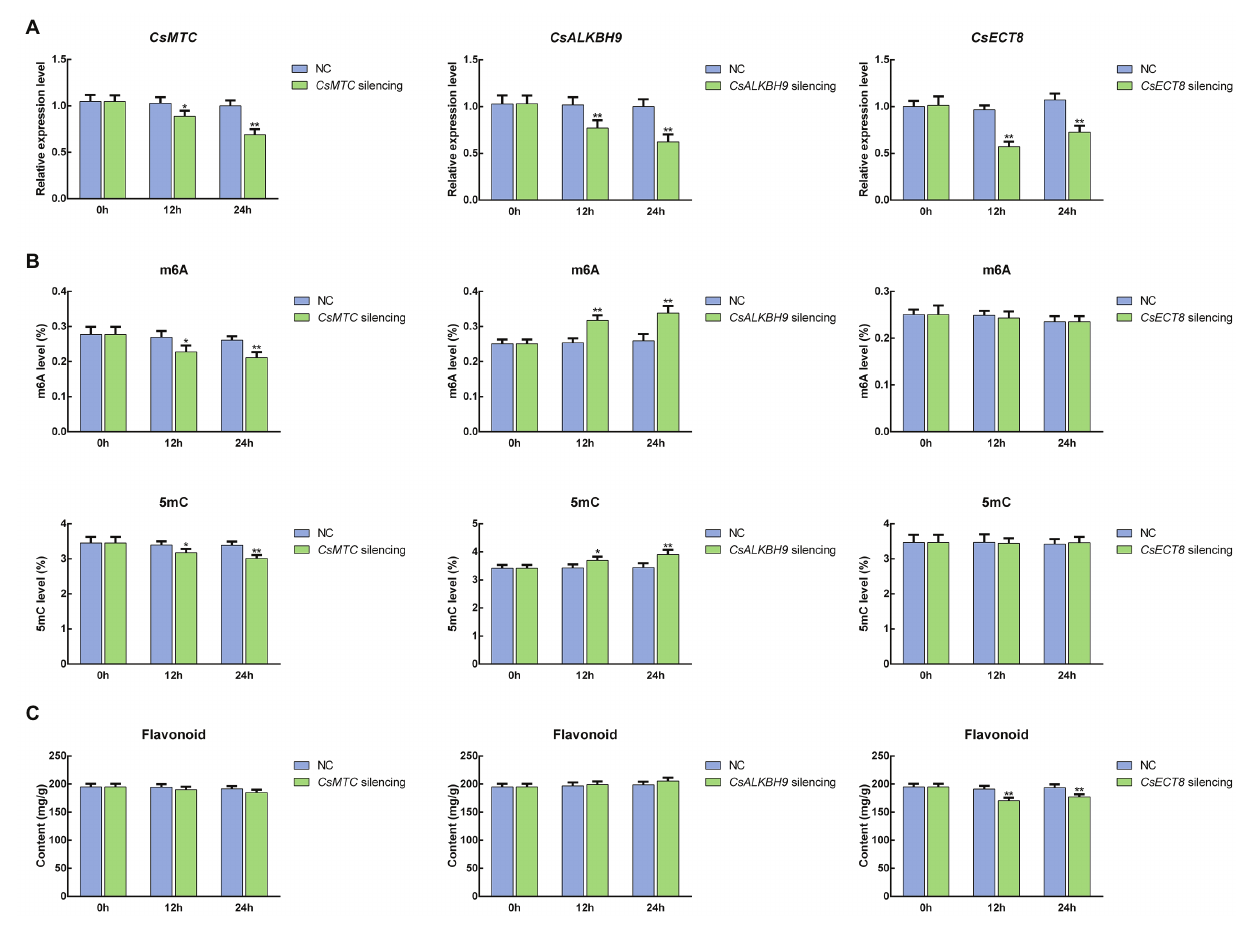
FIGURE 12 | Functional assessment of m6A regulatory genes in tea leaves by siRNA-mediated transient gene silencing. (A) Expression patterns of m6A regulatory genes in siRNA-treated tea leaves. (B) The levels of RNA methylation (m6A) and DNA methylation (5mC) in siRNA-treated tea leaves. (C) Flavonoid content in siRNA-treated tea leaves. Data are presented as mean ± SD. Single asterisk indicates significant difference ( p < 0.05); double asterisks indicate highly significant difference ( p < 0.01). The freshly apical buds with first leaves were picked uniformly from eight-year-old tea plants ( C. sinensis cv. Tieguanyin) at the development stage of one bud with three leaves. Tea shoots (the apical buds with first leaves) were then incubated in 1.5-ml microcentrifuge tubes containing 1 ml of 20 μ M siRNA solution at room temperature. Shoots incubated with the same concentrations of siRNA-negative control (siRNA-NC) were used as the internal control. After 12- and 24-h incubations, the collected shoots were used for RNA isolation and flavonoid